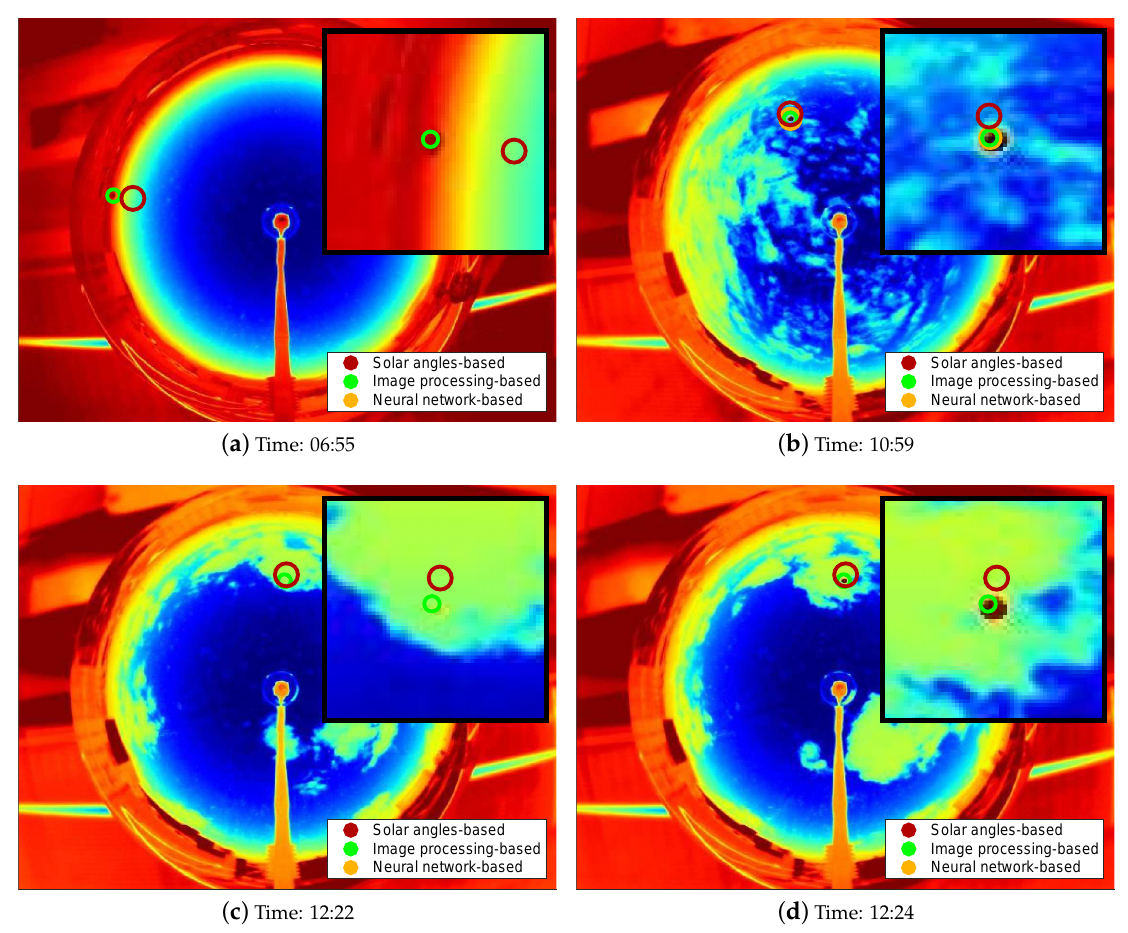
Figure 15. Results of the estimation of the Sun trajectory (black line) with image processing: for each image, the orange circle corresponds to the estimated Sun position at that